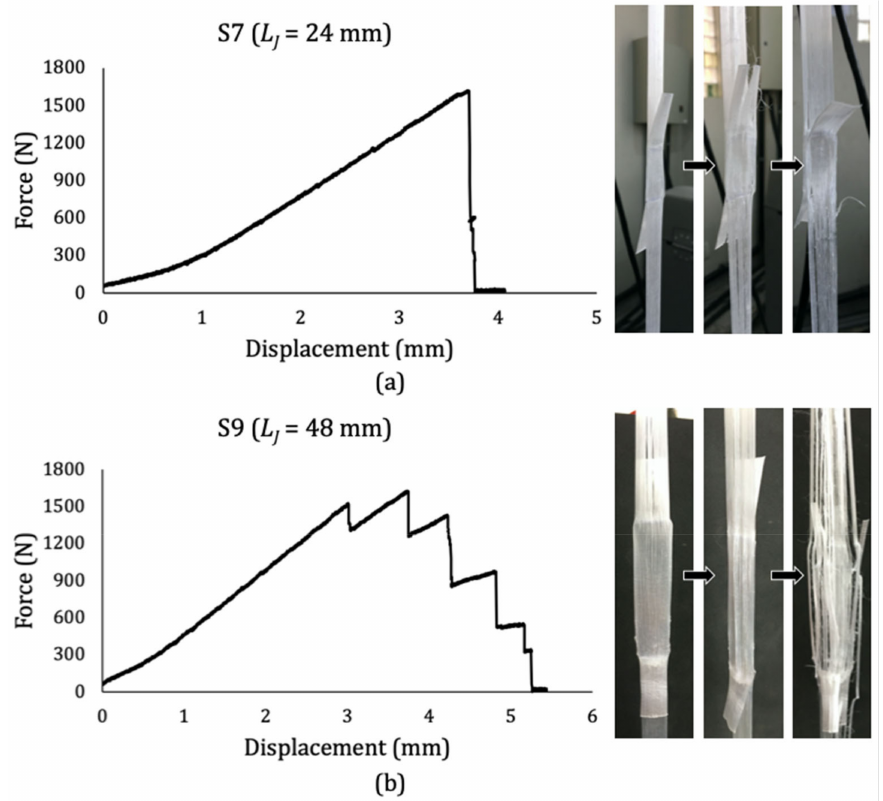
Figure 9. Typical failure progression of ( a ) short and ( b ) long co-cured